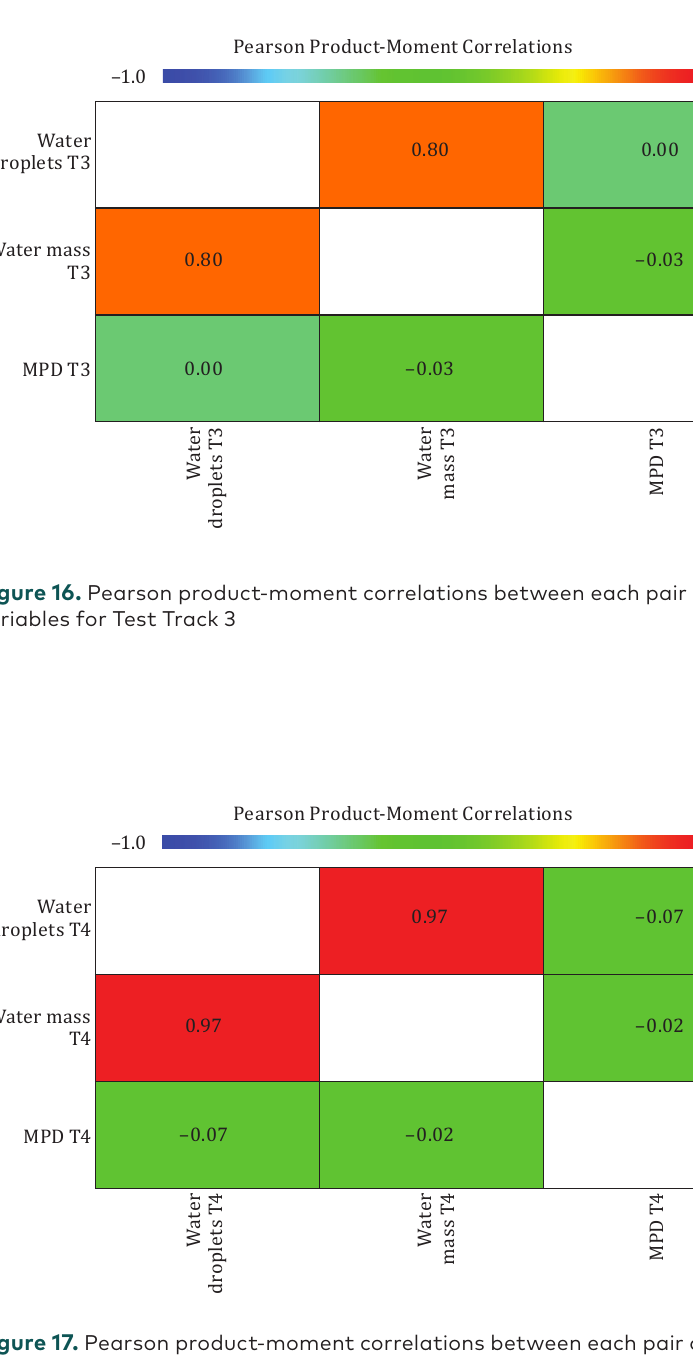
Figure 17. Pearson product-moment correlations between each pair of variables for Test Track